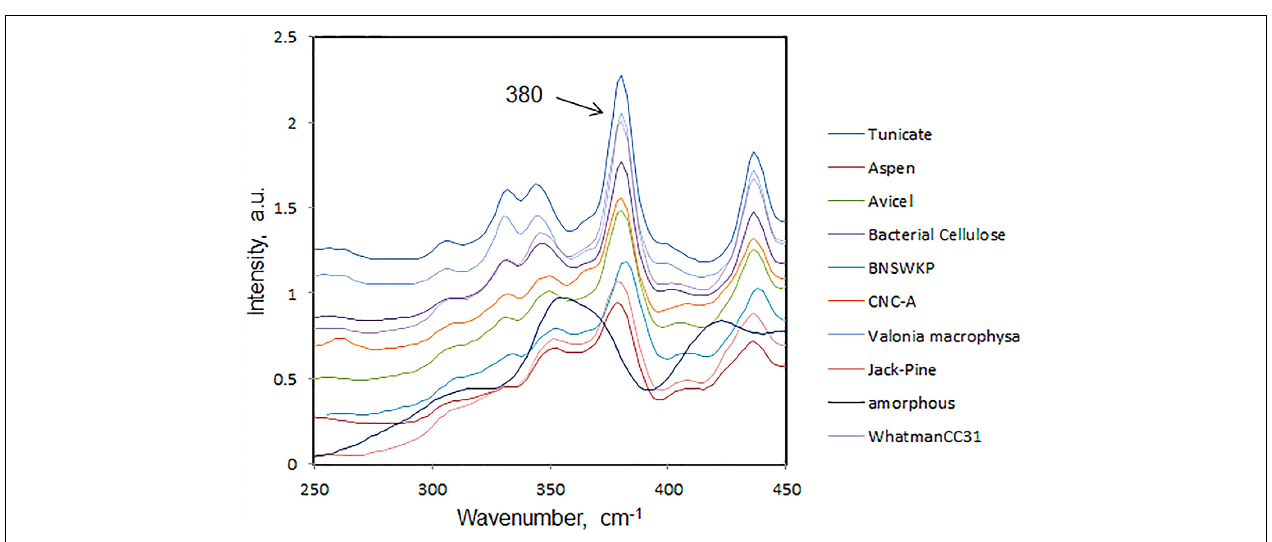
FIGURE 4 | 380cm − 1 region of Raman spectra of a number of cellulose